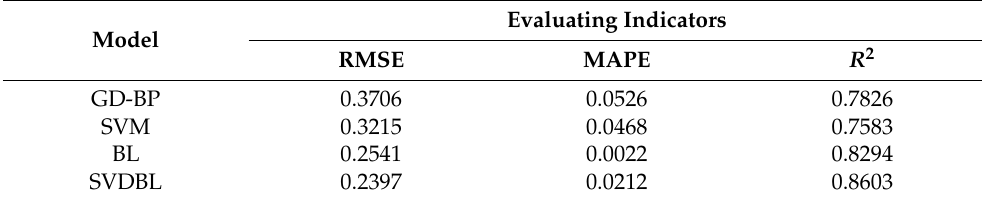
Table 5. Comparison of RMSE, MAPE and R 2 for